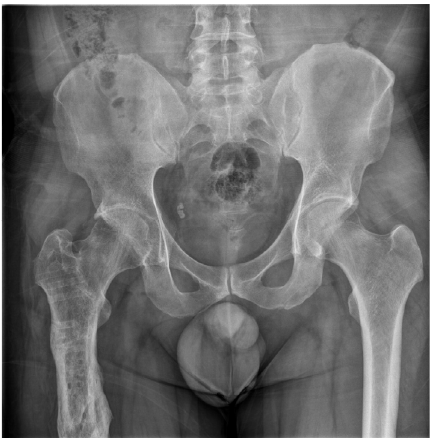
Figure 3. Conventional radiography was performed 6 months after the final operation. The fracture site achieved complete